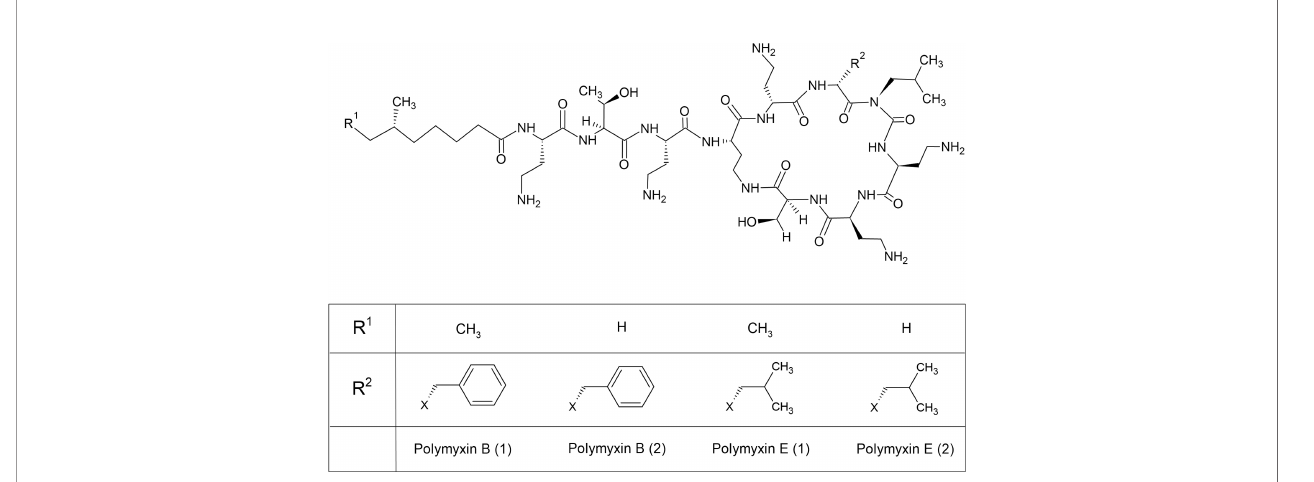
FIGURE 1 | Chemical structures of polymyxin B and